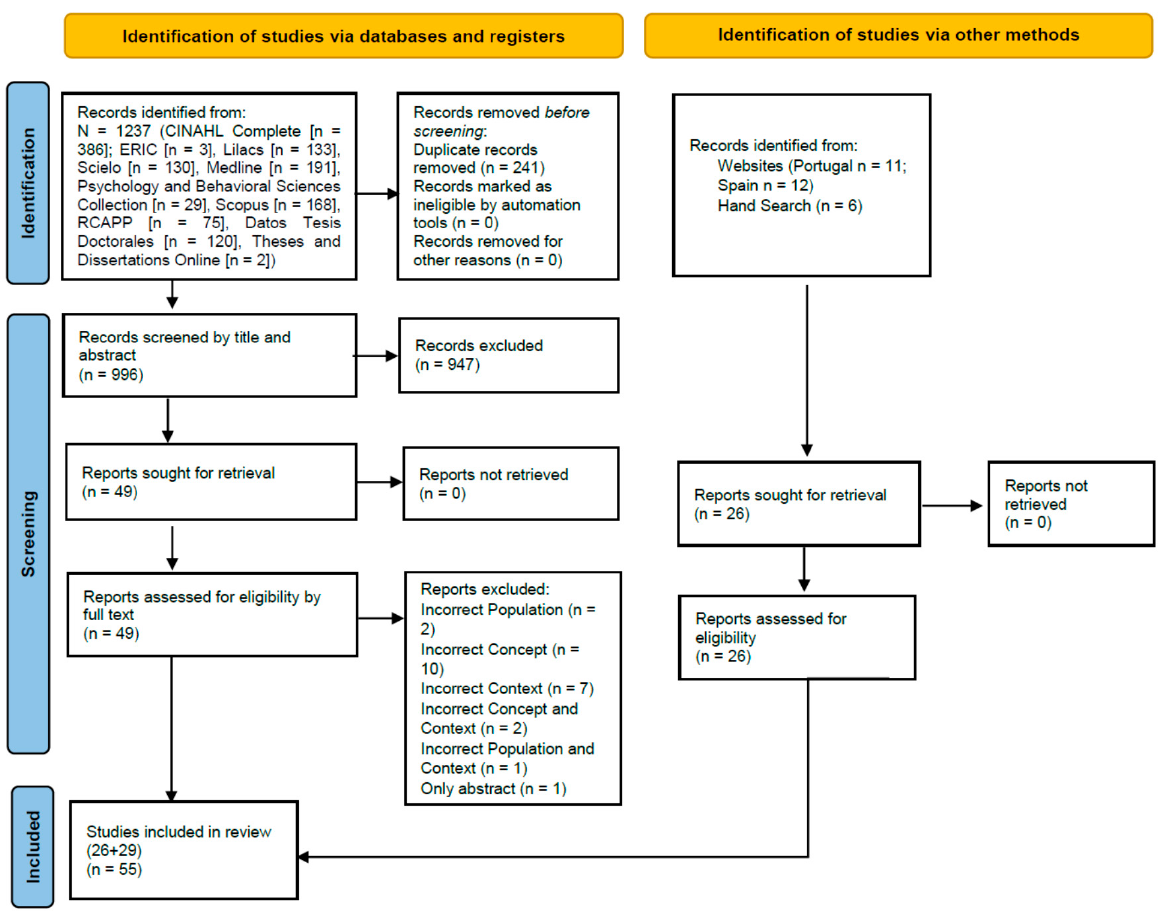
Figure 1. PRISMA 2020 flow diagram for new systematic reviews, which included searches of databases, registers, and other sources [23].